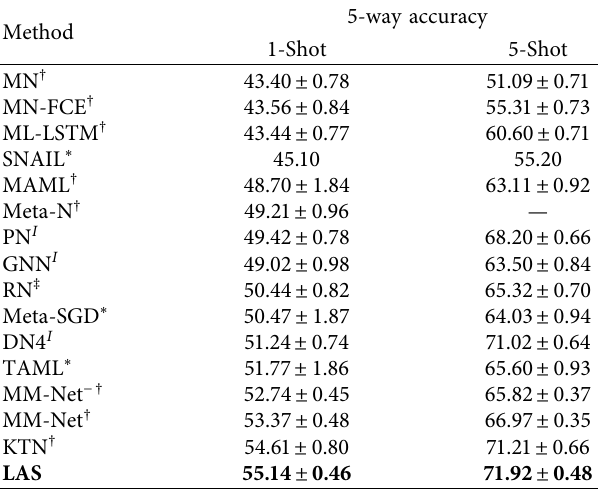
Table 4: Mean accuracy (%) ± CIs (%) of 14 state-of-the-art methods and LAS on the mini-ImageNet dataset with Conv-4 as the